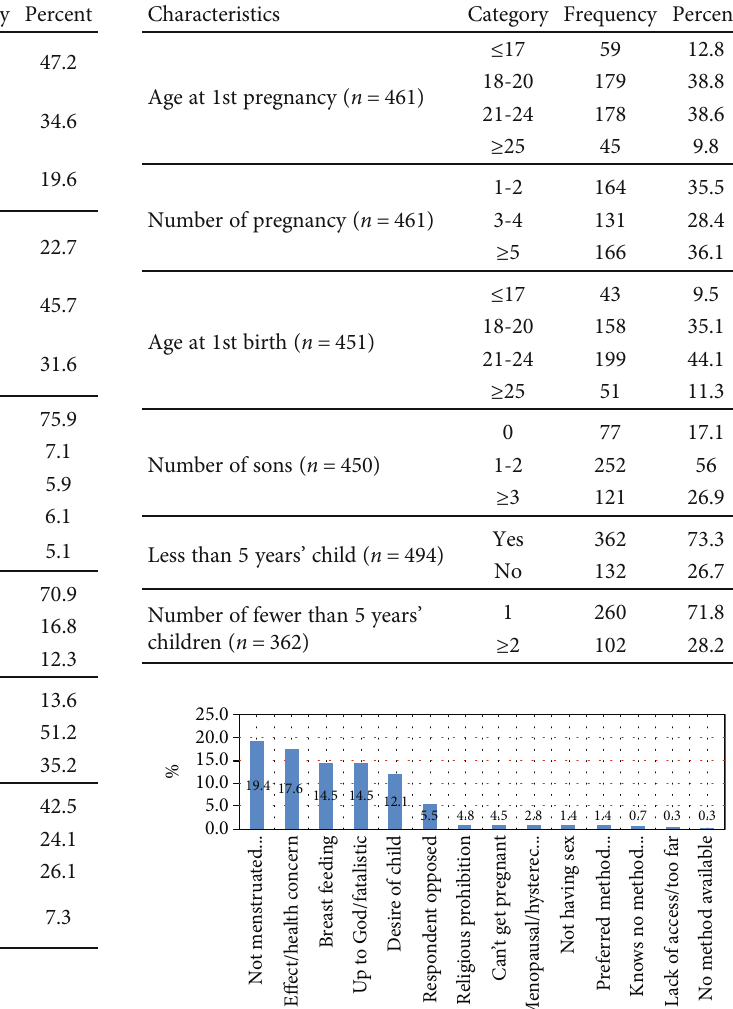
Table 2: Reproductive health characteristics of married reproductive-age women, Toke Kutaye district, West Shoa, Oromia, Ethiopia, March 2019; (supplementary table).